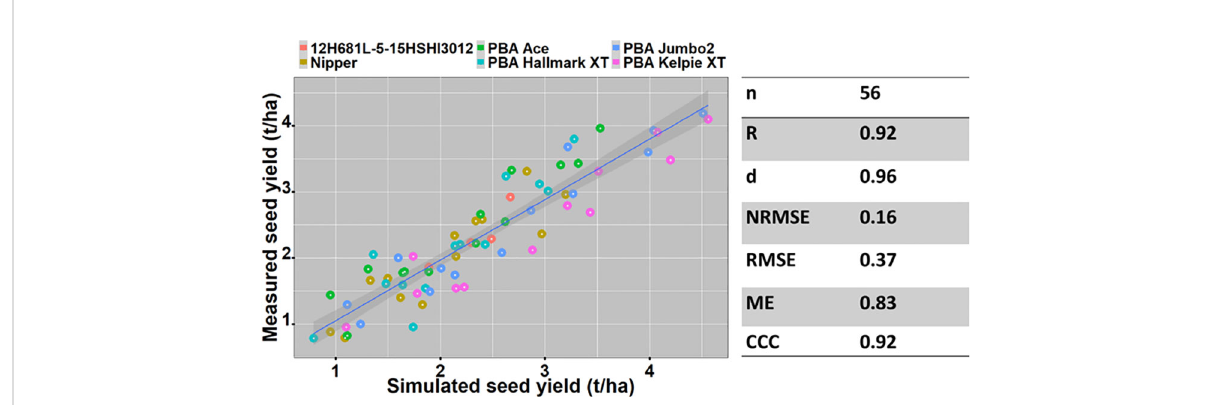
FIGURE 2 The relationship between measured and simulated yield of six lentil varieties between 2016 & 2020 at Horsham and 2016 & 2020 (except in 2018) at